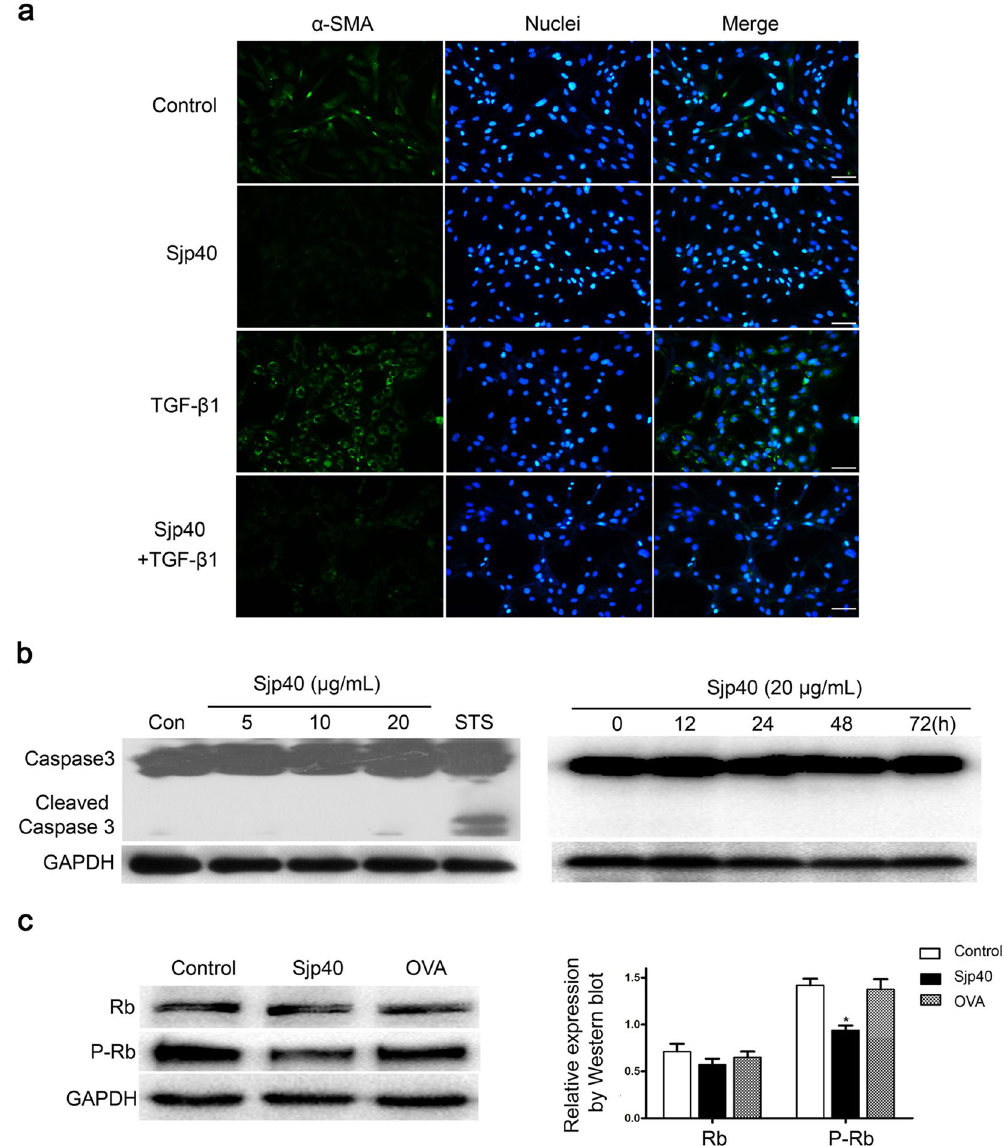
Figure 1. Inhibitory effect of Sjp40 on HSCs activation of LX-2 is independent on the cell apoptosis. ( a ) Effect of Sjp40 on the level of α -SMA in LX-2 cells analyzed by immunofluorescence assay (100 × magnification). After treatment with Sjp40 for 48 h, the protein level of α -SMA was measured by immunofluorescence, and Hoechst 33342 was used to stain the nucleus. The cells were photographed using fluorescence microscope. ( b ) Impact of Sjp40 on LX-2 cells apoptosis. The cells were exposed to different concentrations of Sjp40 (5, 10, 20 μ g/mL) or Staurosporin (STS) as a positive control, and at the different times (0, 12, 24, 48, 72 h). And then the level of cleaved-caspase-3 was analyzed by Western blot assay. ( c ) Effects of Sjp40 on the expression of cell cycle regulatory proteins. The protein levels of Rb and P-Rb in LX-2 cells treated with or without Sjp40 were analyzed by Western blot assay. * p < 0.05 compared to control group. Bar: 50